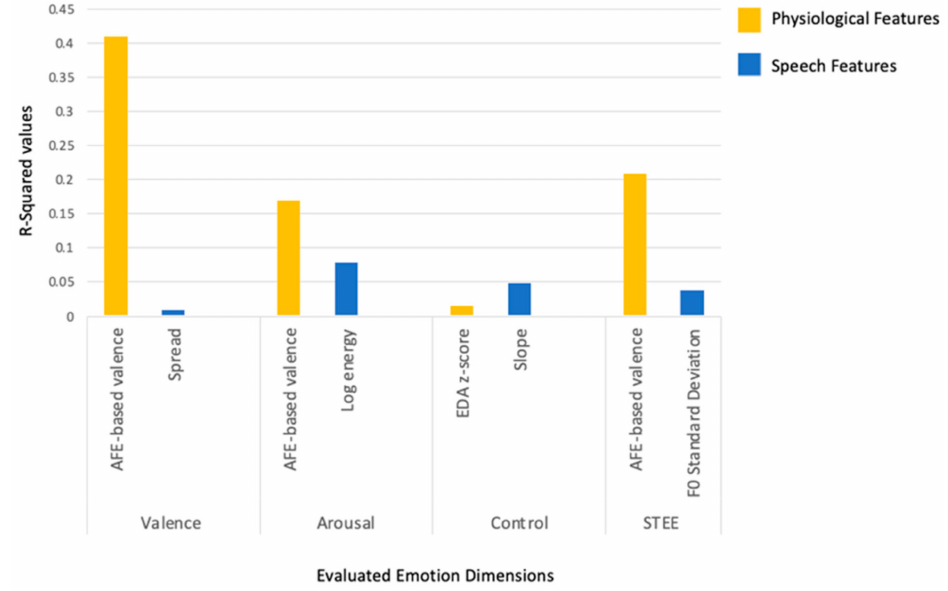
Figure 6. Bar chart of relationship strengths between physiological and speech features per